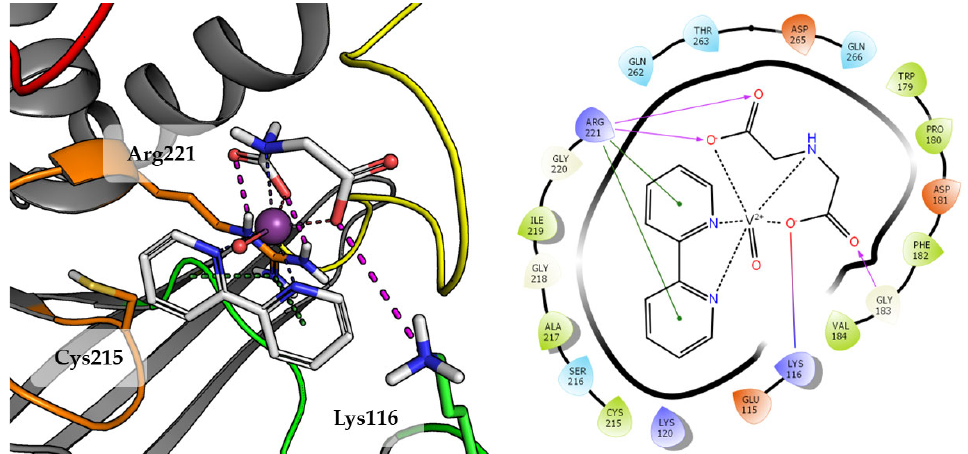
Figure 6. Docking result of Compound 3 to the PTP1B active site (PDB: 1ONZ). Left panel presents a studied compound as white sticks with protein represented by a gray cartoon. Significant loops are highlighted with separate colors; P ‐ loop in orange, WPD ‐ loop in yellow, E ‐ loop in green, and Q ‐ loop in red. The most important amino acids are represented as sticks with the same color code. Coordinate bonds are marked with thin dotted lines. Hydrogen bonds are marked in magenta, ionic interaction in red, aromatic π‐π , CH ‐π and cation ‐π in green. Right panel presents 2D ligand interaction diagram.